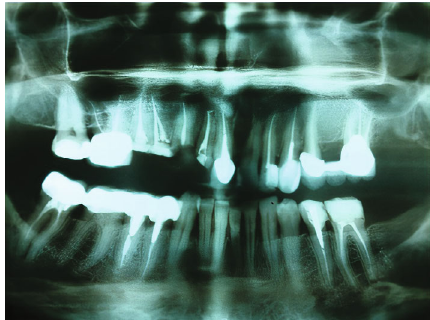
Figure 3: Panoramic radiographic view of patient ’ s teeth.